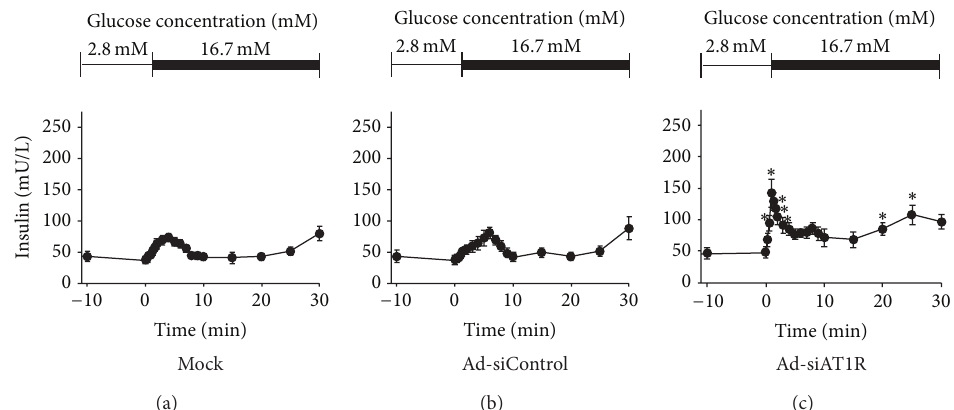
Figure 6: Insulin secretion by islet perifusion in Ad-siAT1R, Ad-siControl and Mock group. Results are represented as mean ± SD for three duplicate experiments. ∗ 𝑃 < 0.05 versus Ad-siControl.